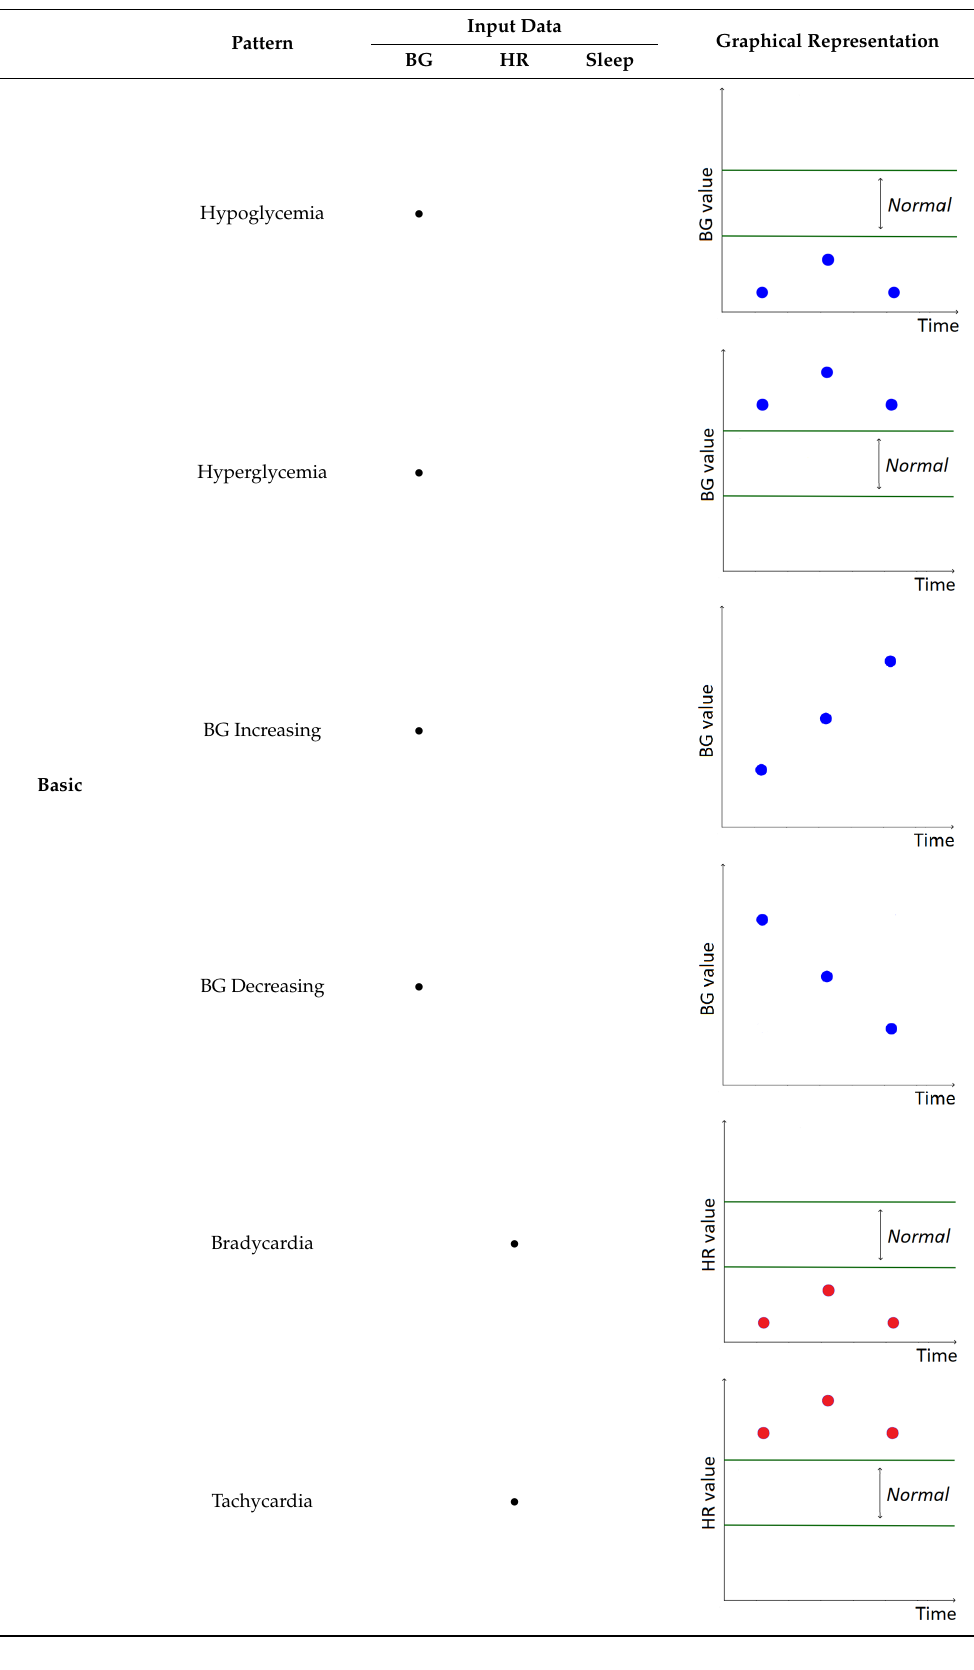
Table 1. Patterns of interest to evaluate the diabetes outcome. Red dots represent BG measurements; blue dots represent HR measurements.